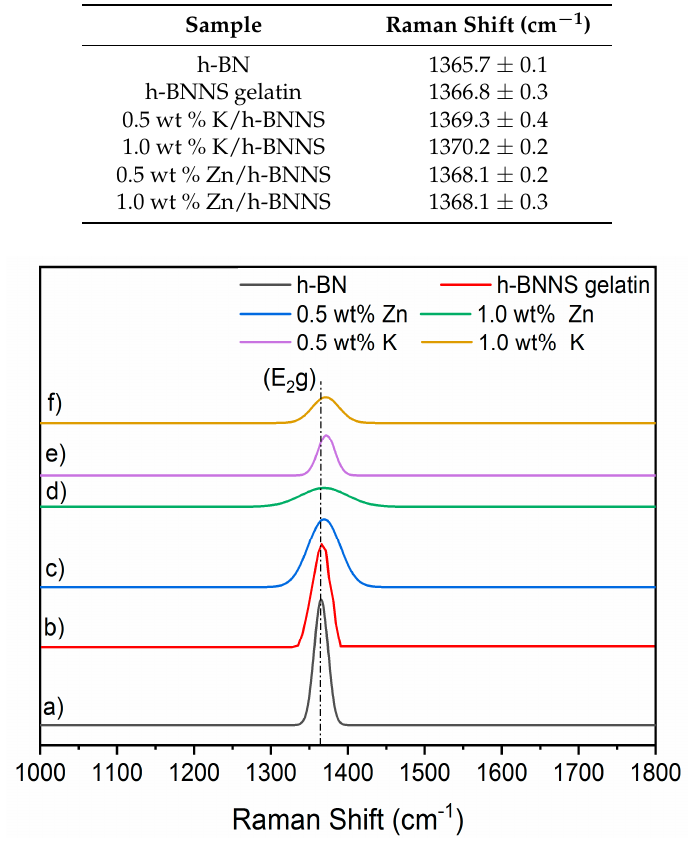
Figure 4. Comparative Raman spectra of ( a ) pristine h-BN; ( b ) h-BNNS gelatin; ( c ) h-BNNS exfoliated by intercalation of 0.5 wt % ZnCl 2 ; ( d ) h-BNNS exfoliated by intercalation of 1.0 wt % ZnCl 2 ; ( e ) h-BNNS exfoliated by intercalation of 0.5 wt % KCl; and ( f ) h-BNNS exfoliated by intercalation of 1.0 wt %